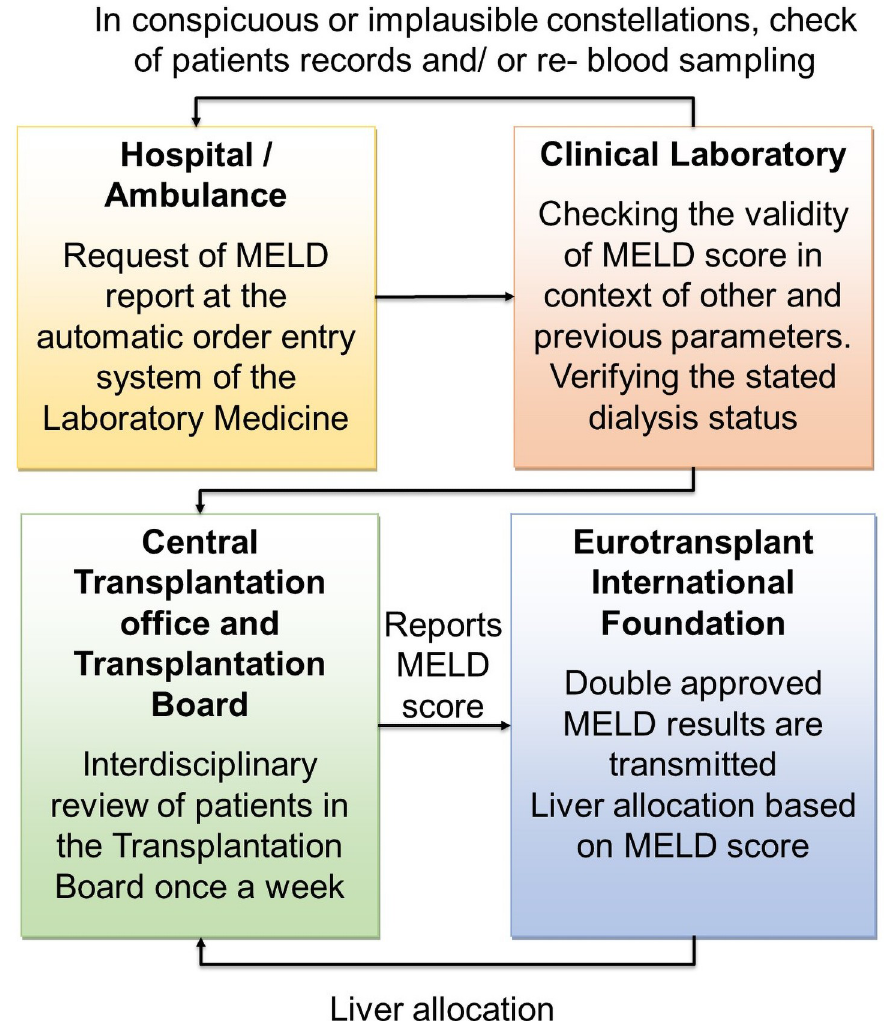
Fig 1. Flow sheet of quality approved lab-MELD diagnostic at the University Hospital